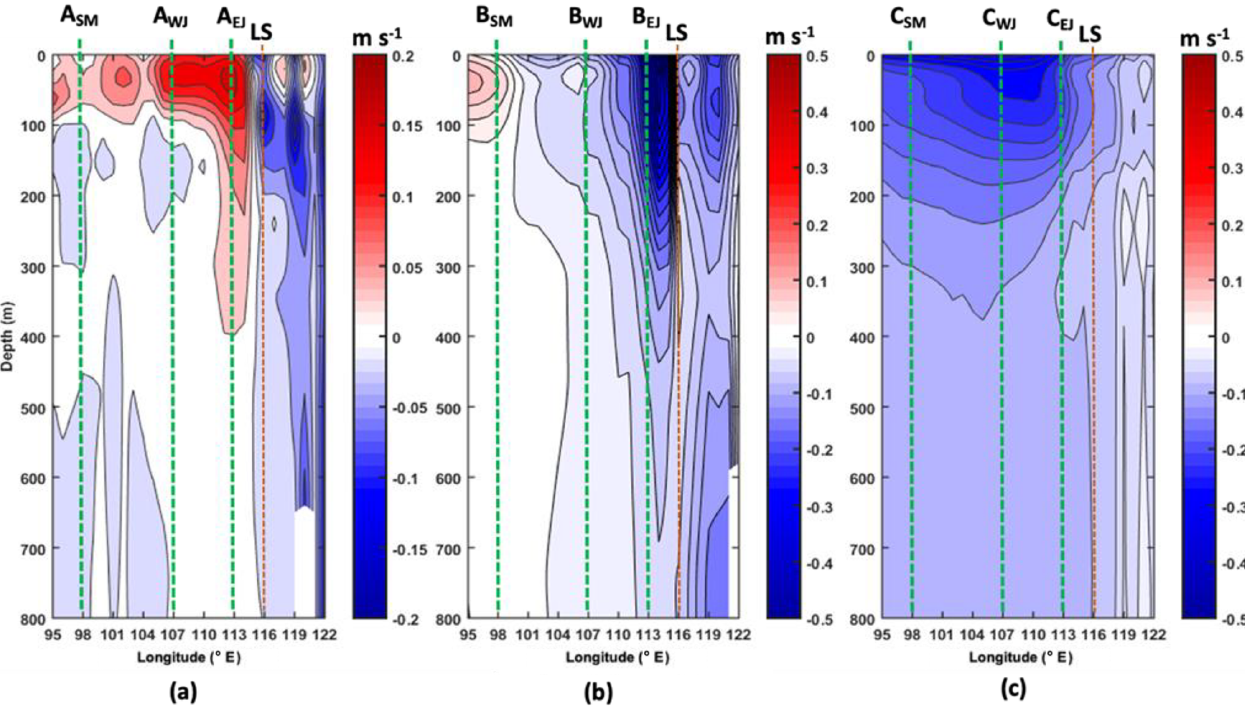
Figure 4. Longitude–depth profiles of mean zonal currents along (a) Transect A, (b) Transect B, and (c) Transect C. Positive (negative) values of the zonal currents indicate eastward (westward) currents. Dashed green lines denote the longitudes of the nine selected points, whereas the dashed orange line denotes the longitude of Lombok Strait